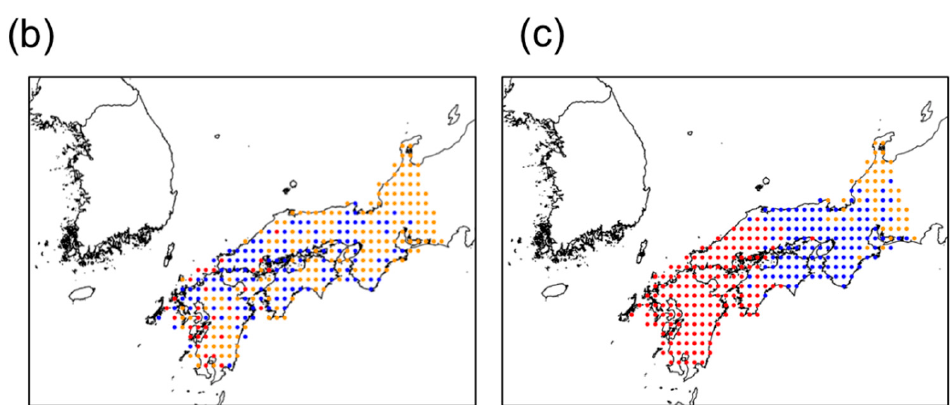
Figure 5. Schematic view and scenario of the formation process. ( a ) scenario with replacement for Nipponocypris temminckii :